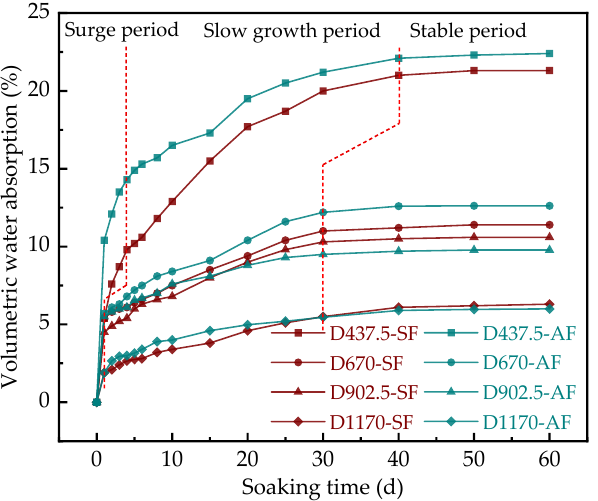
Figure 12. The variation in the volume of water absorption by FMLSB with time.